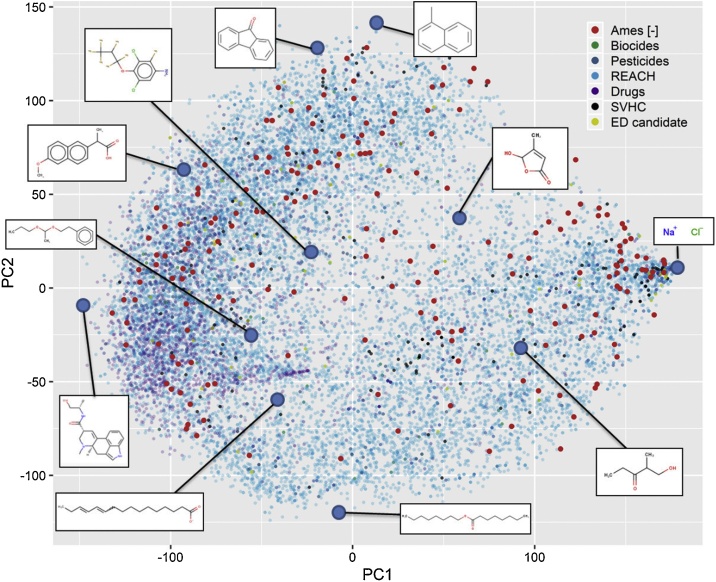
Chemical space of the Ames-negative substances. Chemical space of substances found in the Ames-negative database (207, red dots), and in the lists of REACH registered substances (15600), drugs (2388), pesticides (317), biocides (127), substances of very high concern (SVHCs) (199), and endocrine disruptor candidates (75) [[21], [22], [23], [24], [25], [26]]. The number of chemicals in each dataset corresponds to the number of substances for which a structure could be retrieved and is shown in brackets. Transition metal salts (e.g. Ti, V, Fe), natural products, and unknown, variable composition, or complex reaction products and biological materials (UVCBs) are not included. Axes and positions of the substances correspond to the first two principal components of the similarity matrix of the substances built using the RDKit [28] atomic pairs fingerprints. A total of 18904 substances are shown in the chemical space.